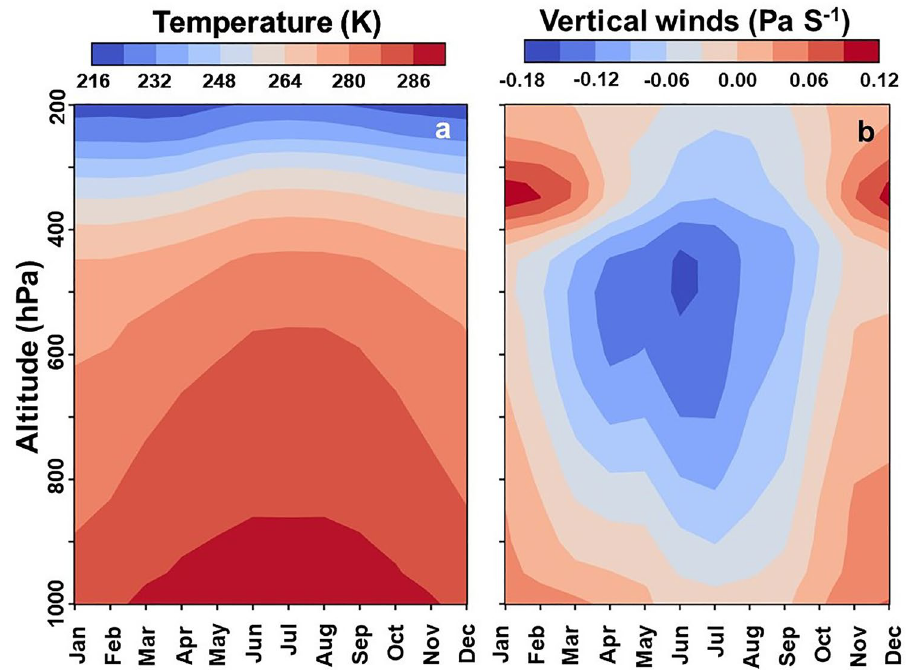
Figure 5. Deep Convective cells observed during the ISM season. The vertical profile for monthly air temperature and vertical wind velocity for the period from 1979 to 2018 highlighting formation of deeper convective cells during the ISM season. These deeper convective cells formed during ISM seem to be smaller in geographical extent than large scale organized convective cell, and localised as evident from variation in CAPE, CIN and ET values over a smaller geographical extent (See Fig. 2). The plots are generated for the rectangular grid ranging from 23.72°N–28°N, and